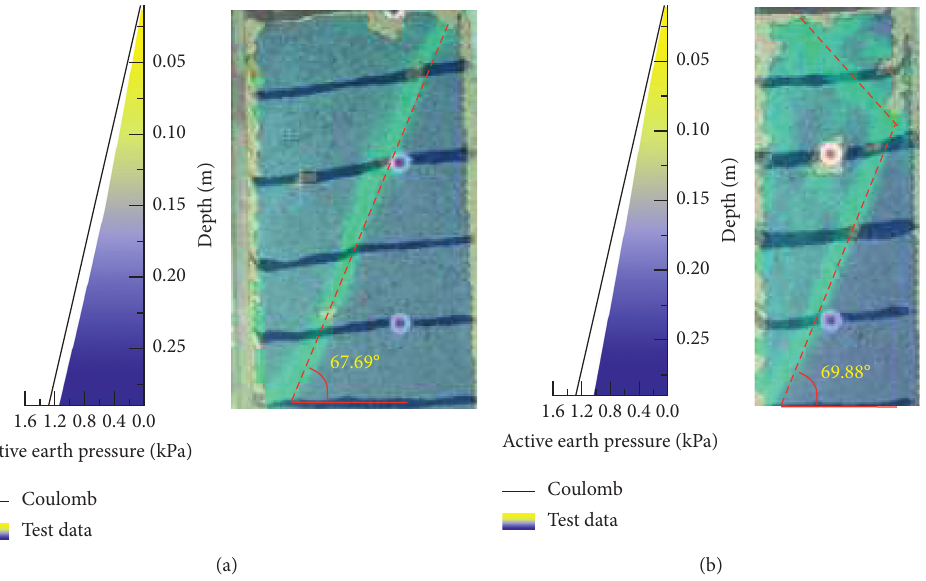
Figure 6: Strain contour of the narrow backfill: (a) B / H � 0 . 5; (b) B / H � 0 .